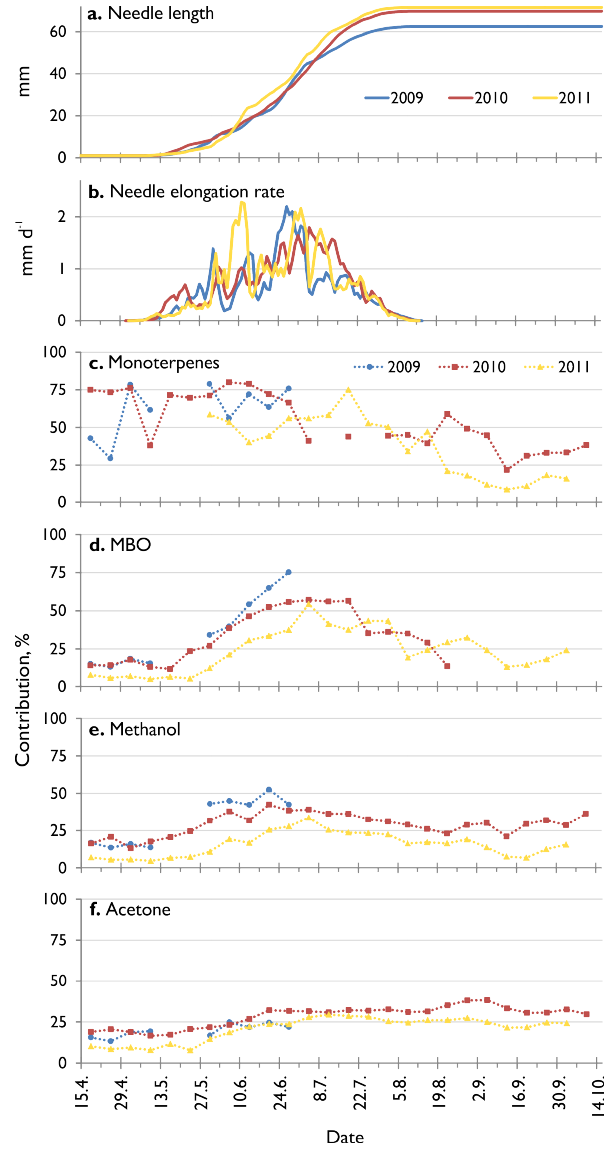
Fig. 3. The growth of needles and the relative contribution of devel- oping shoots to the emissions of the whole foliage. The points rep- resent one week averages in 3consecutive years (2009–2011). (a) length of growing needles; (b) elongation rate of growing needles. The contribution of developing needle age class to canopy emis- sions of (c) monoterpenes, (d) MBO, (e) methanol, and (f) acetone.